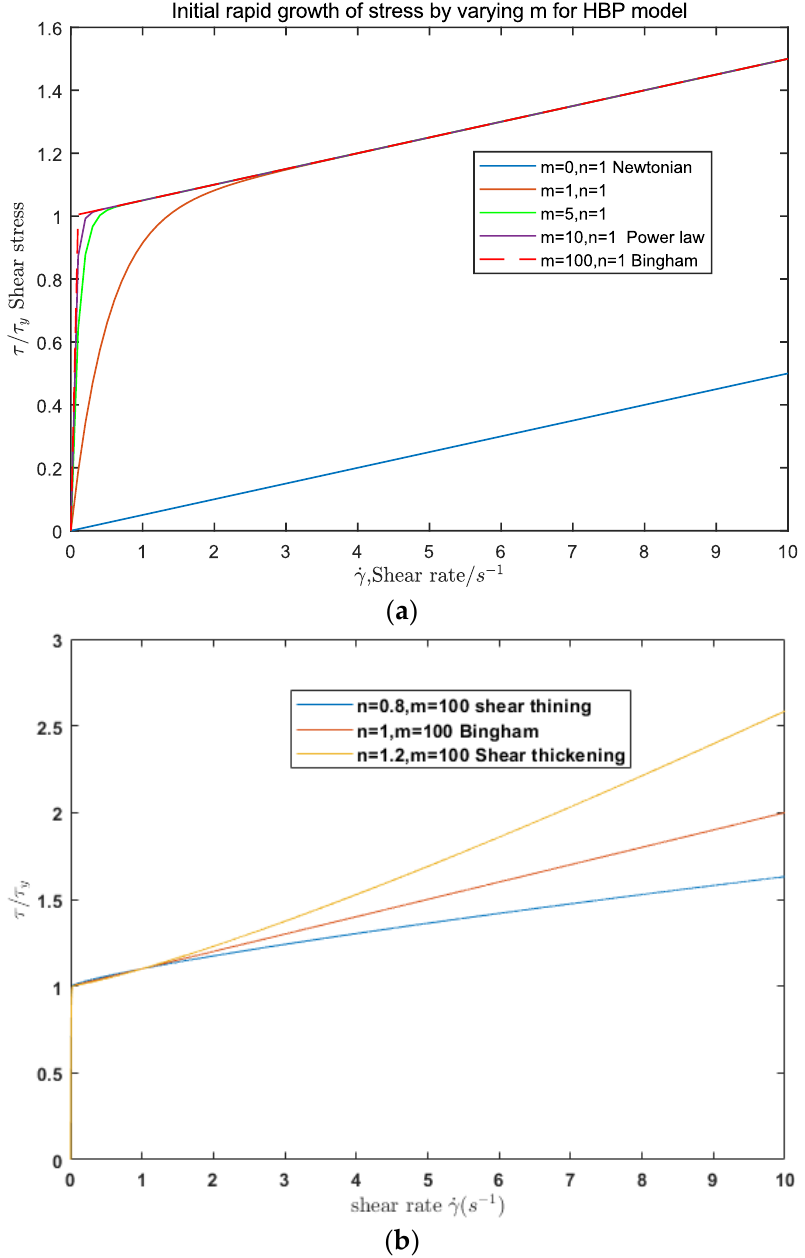
Figure 2. Parameter analysis of the HBP model; ( a ) is for coefficient m ( n = 1) and ( b ) is for coefficient n ( m = 100).